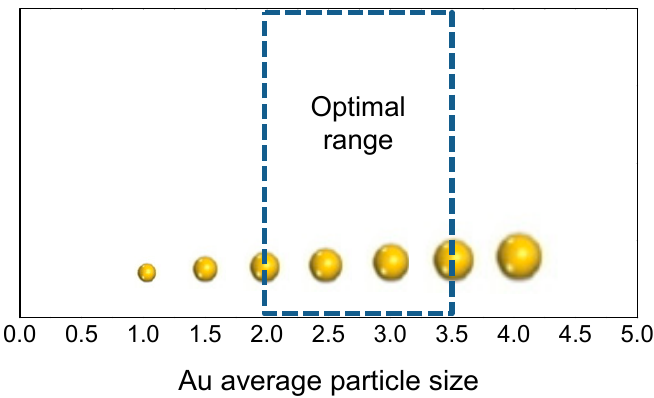
Figure 3. Optimal range for gold mean size in Au/ZrO 2 catalysts for 2 ‐ FA oxidative esterification to methyl ‐ 2 ‐ furoate.